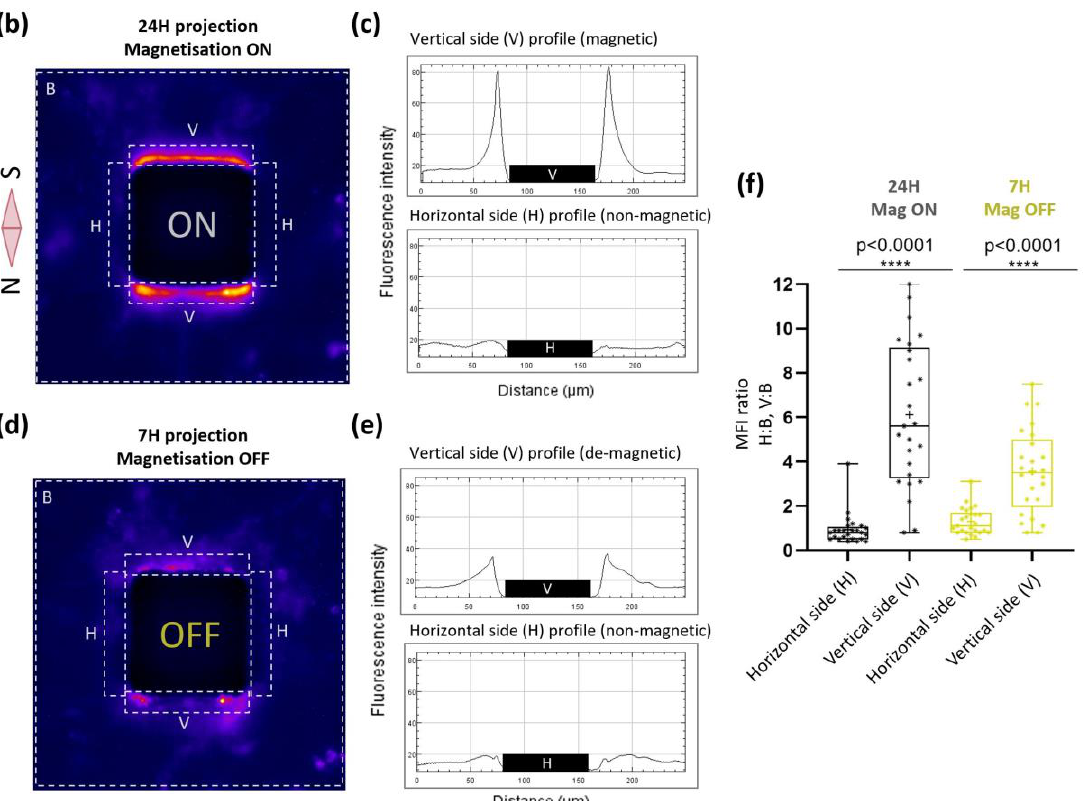
Figure 3. Parallelized magnetic manipulation SHSy-5y cells. ( a ) Images of one representative field of view at di ff erent times during magnetic attraction (24 h), showing collective cellular trapping at the magnetic pole, consequently to the attraction of the magnetic endosomes, depicted in red. After removing the magnetic field (OFF State), captured cells are released and move away from the pillar (last two images). ( b , d ) Average images ( n = 25) of mean fluorescence intensity time projection comprising the di ff erent areas measured to estimate the magnetic cellular trapping and relaxation: H (horizontal axis, control), V (vertical axis with and without an external field) and B (background area). ( c , e ) Curves representing the fluorescent intensity along V and along H. ( f ) Histogram comparing the cell enrichment between the region close to the magnetic pole (V) and the region orthogonal to the magnetic poles, where no magnetic field gradient is produced ((H region, control)). MFI = mean fluorescence intensity.